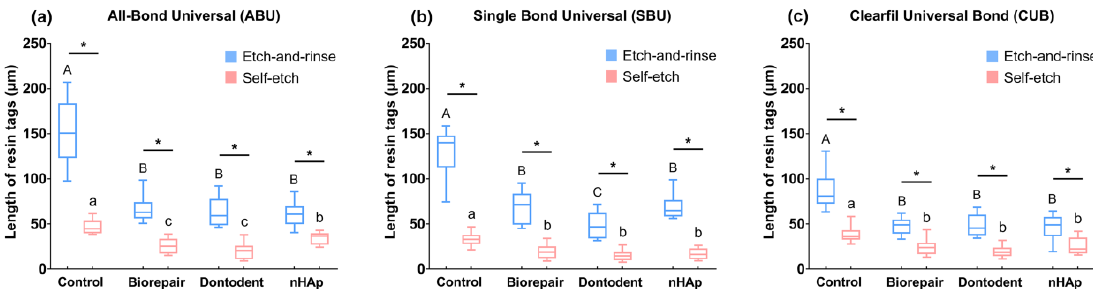
Figure 8. Resin tags ’ length of universal adhesives in etch-and-rinse mode or self-etch mode. ( a ) All-Bond Universal. ( b ) Single Bond Universal. ( c ) Clearfil Universal Bond. Different superscript uppercase letters indicate significant differences in etch-and-rinse mode ( p < 0.05). Different superscript lowercase letters indicate significant differences in self-etch mode ( p < 0.05). * denotes a significant difference between the etch-and-rinse mode and self-etch mode ( p <